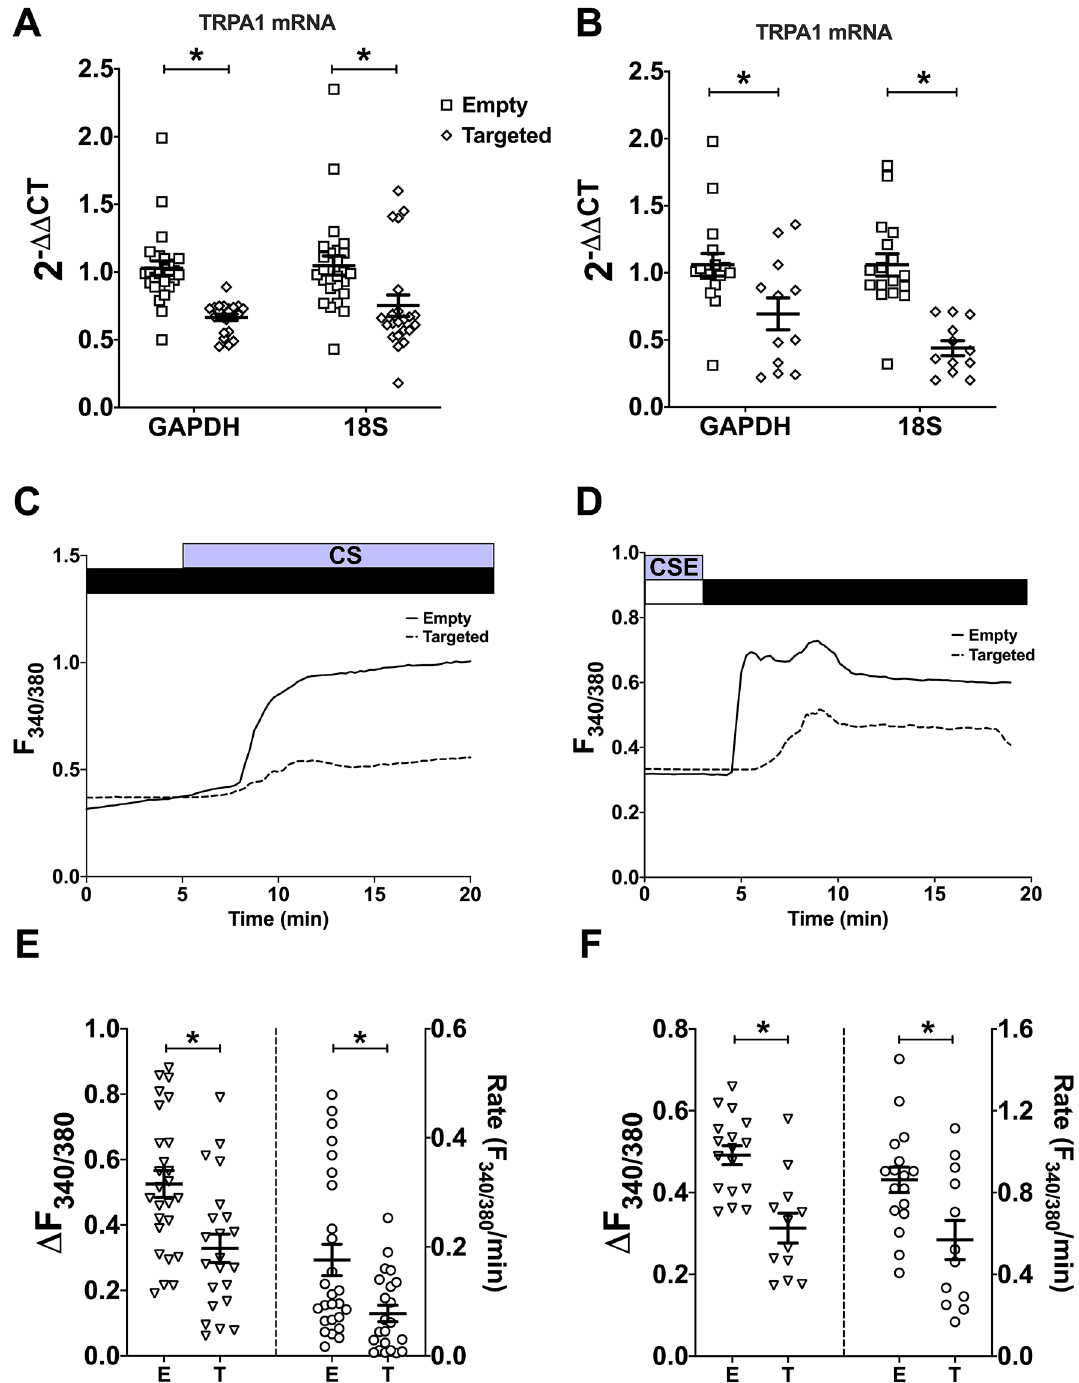
Figure 6. TRPA1 knockdown significantly attenuated CS- and CSE-induced Ca 2+ influx. hASMC were transfected with shRNA containing either the empty (E) vector, or the vector targeted (T) towards TRPA1. (A,B) Knockdown efficiency of TRPA1 in hASMC subjected to CS (A) or CSE (B) experiments, presented as mean ± SEM. TRPA1 mRNA expression is reported as 2 −ΔΔCT (TRPA1 expression relative to the average TRPA1 expression of coverslips transfected with the empty vector in the same plate, day/donor-matched) normalised to two different housekeeping genes, GAPDH and 18S. (C,D ) Representative Ca 2+ imaging trace from separate experiments tracking changes in [Ca 2+ ] i following puffing one whole cigarette (C) or following Ca 2+ addback after 5-min perfusion with 10% CSE in transfected hASMC (D) . (E,F) Summary of amplitude and rate of CS- (E) or CSE-activated (F) Ca 2+ influx in transfected hASMC, respectively, presented as mean ± SEM. Unpaired t-test was performed between the groups transfected with empty vector and those transfected with the TRPA1 targeted vector (3–4 independent donors; n = 10–26). *p <